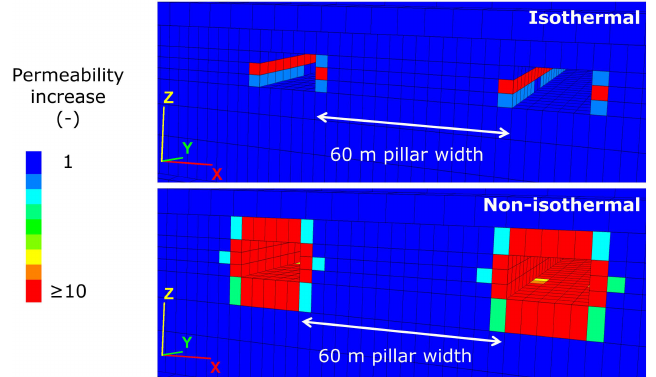
Figure 4. Normalized permeability changes (-) for the: isothermal ( top ); and non-isothermal ( bottom ) scenarios with a pillar width of 60 m show significant differences in their spatial distribution due to the lack of temperature-induced stress effects in the non-isothermal